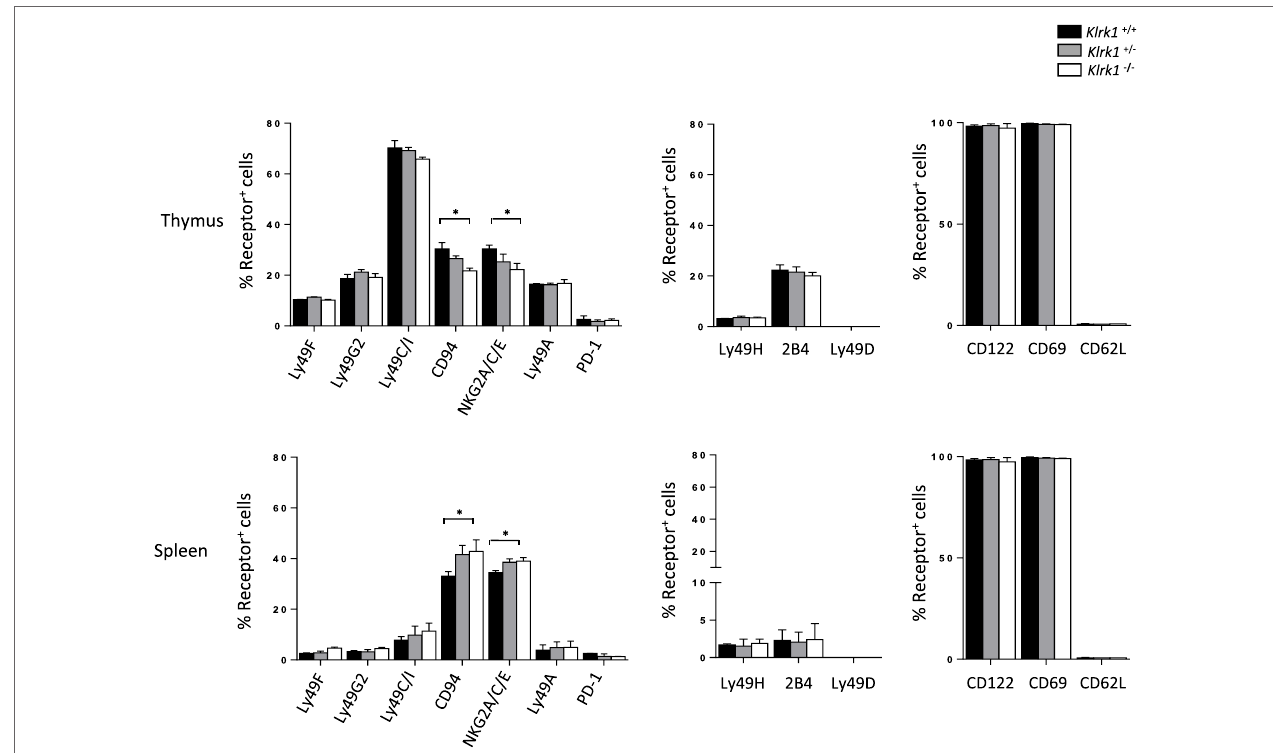
FigUre 2 | The expression of invariant natural killer T cell (iNKT) cell phenotypic makers is preserved in the absence of NK group 2 member D. Frequencies of inhibitory (left) and activating (middle) NK-receptors, and other activating receptors (right) among NK1.1 + iNKT cells in the thymus and spleen. iNKT cells are defined as tet + HSA low in the thymus or tet + B220 − in the spleen. Data are from five experiments where three mice aged 5- to 6-week old were used per experiment and presented as mean ± SD. Numbers represent percentages. Significance is represented by an asterisk and was evaluated with non-parametric Mann–Whitney U